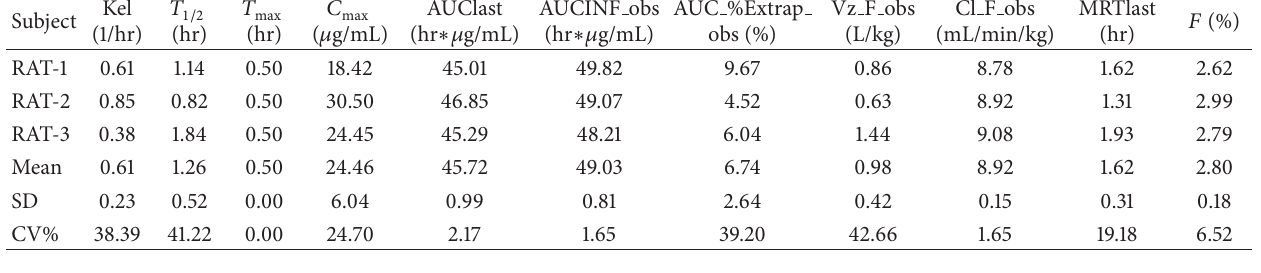
Table 5: Pharmacokinetic parameters of CrEL-PEG after oral administration at 0.018g/kg dose (PEG component) in male Sprague Dawley rats.